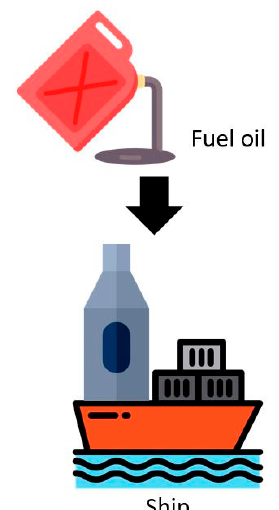
Figure 5. LCA model for operation phase of scrubber system.